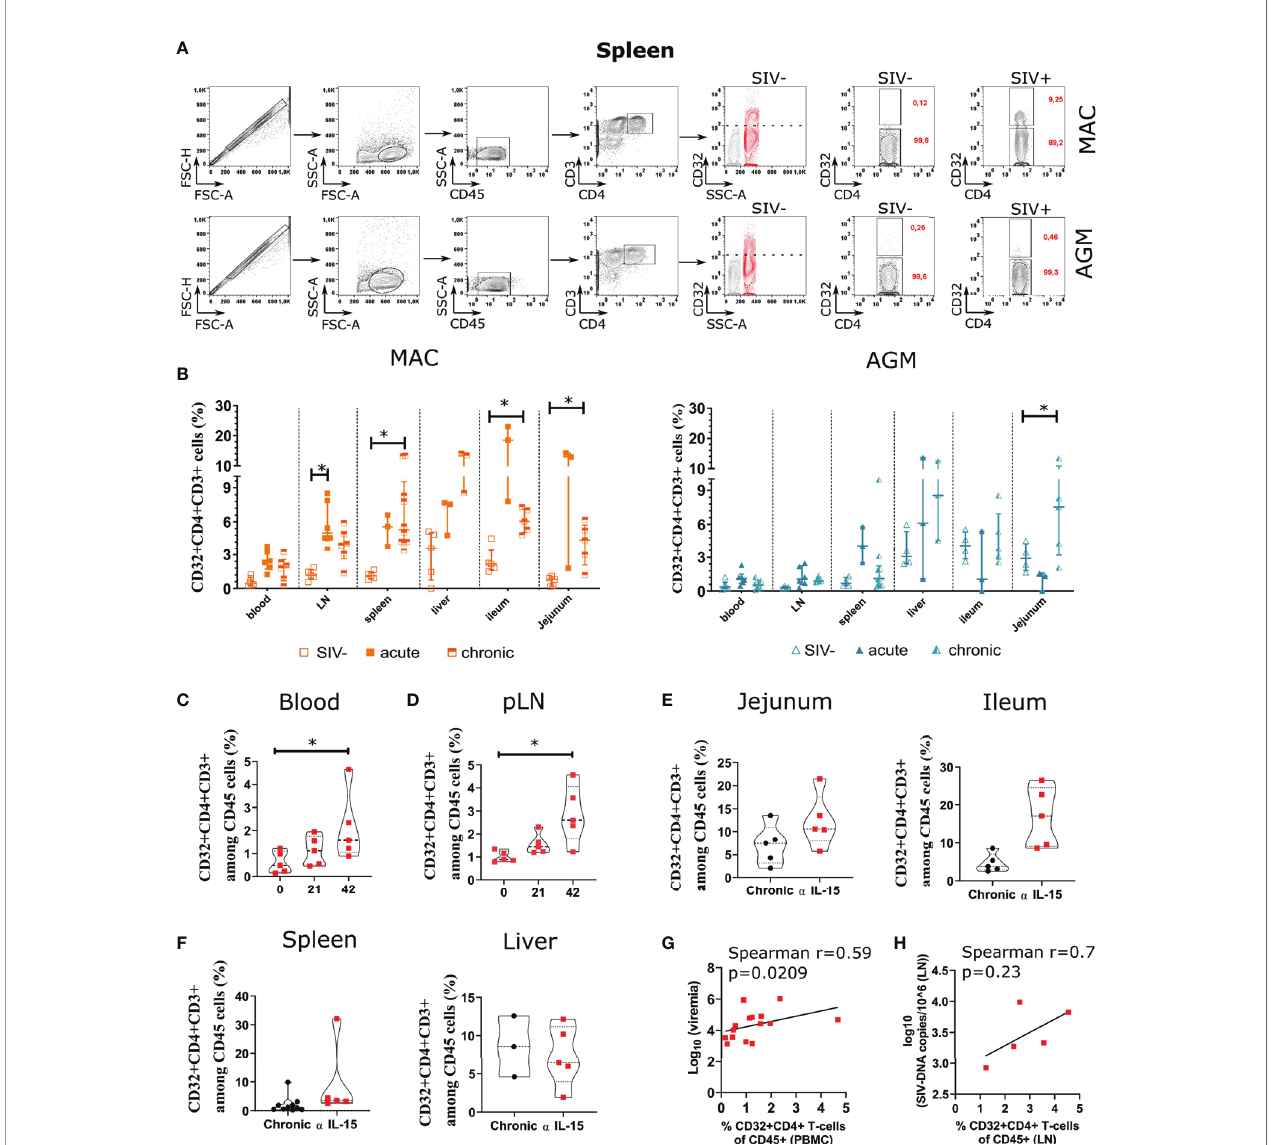
FIGURE 1 | Quanti fi cation of CD4+ T cells expressing CD32 and/or viral RNA in tissues during pathogenic and natural host SIV infections. (A) Representative gating strategy for CD32+CD4+ T cells. A representative example from the spleen of a chronically infected cynomolgus macaque (MAC) (upper part), and a chronically infected AGM (lower part) are shown. The position of the CD32 + gate on CD4+ T cells was chosen according to the level of CD32 expression on myeloid cells (overlaid red population) in SIV-negative monkeys. In red is indicated the percentage of the gated population in both SIV- and SIV+ monkeys. (B) Graphs showing the frequency of CD32+CD4+ T cells in six tissues in SIV-uninfected, SIV acutely infected (day 9 p.i.) and SIV chronically infected MAC (orange) and AGM (blue). Values indicate the percentage of CD32+CD4+ T cells among total CD4+ T cells. Each individual monkey is represented by a square (MAC) or a triangle (AGM). The number of animals analyzed varied from three to six, depending on the compartment and time point studied. Time points or tissues with only three animals corresponding to liver and acute infection in gut were not included in the statistical comparisons. (C, D) Dynamics of CD32+CD4+CD3+ cells in blood and pLN of chronically SIV-infected AGM before, during and after anti-IL-15 administration. CD4+T cells were analyzed in blood and pLN before and at days 21 and 42 after initiation of anti-IL-15 treatment. The anti-IL-15 treatment of the chronically infected AGM (n=5 animals) has been previously reported (38). Violin plots showing the frequency of CD32+ CD4+T cells among CD45+ cells in blood (C) and pLN (D) in non-treated and anti-IL-15 treated chronically SIV-infected AGM. (E, F) Comparison of CD32+CD4+ T cells in tissues at necropsy, between chronically infected AGM treated or not with anti-IL-15. Violin plots show the distribution of CD32+CD4+CD3+ cells among CD45+ cells from chronically infected AGM (black) and anti-IL-15 treated chronically infected AGM (red) in the indicated tissue. (G) Frequencies of CD32+CD4+ T cells in PBMC of treated animals (day 42 post-anti-IL15) were plotted against viremia levels. (H) The frequencies of CD32+CD4+ T cells of treated animals (day 42 post-anti-IL15) were plotted against ca-viral DNA in LN. In (B) , statistical differences were assessed by ANOVA with Tukey adjustment for multiple comparisons. In (C – F) , a Kruskal-Wallis test was applied. Asterisks indicate p-values < 0.05. Each symbol represents a single